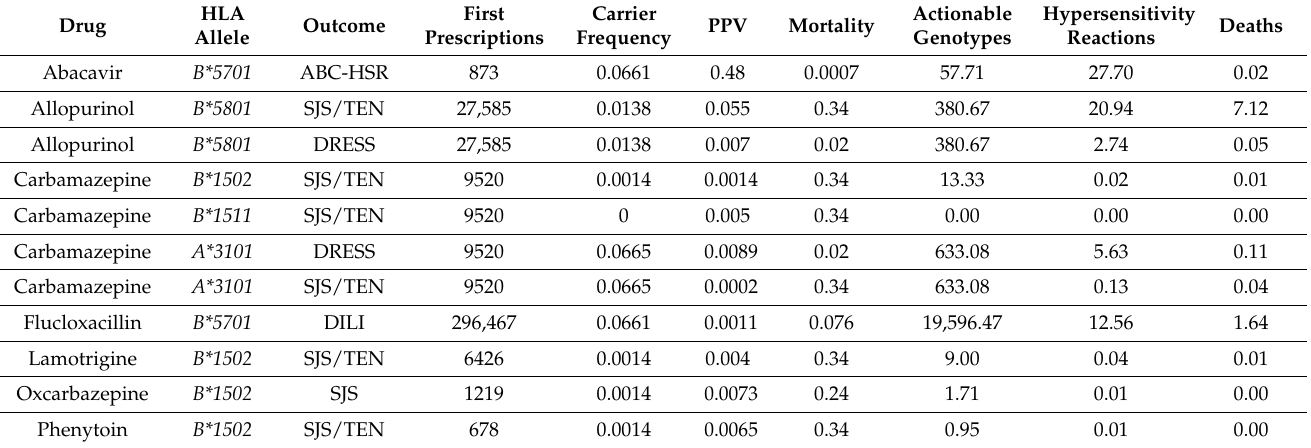
Table 5. An overview of actionable genotypes amongst drug initiators and the estimated number of hypersensitivity reactions and deaths caused by hypersensitivity reactions that can be prevented by HLA